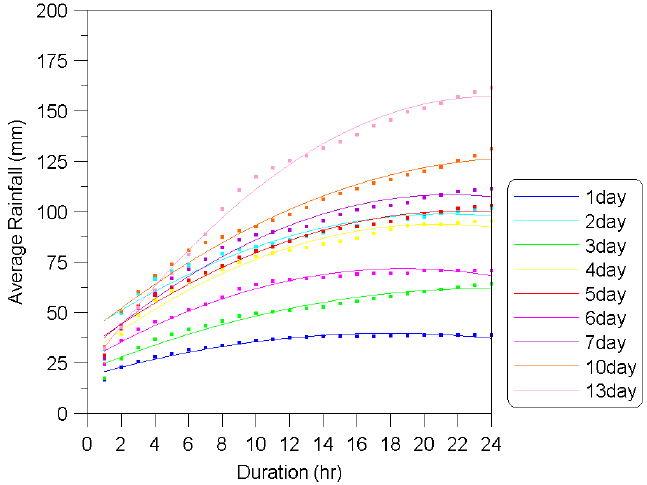
Figure 6. The rainfall by duration according to the length of natural disaster.